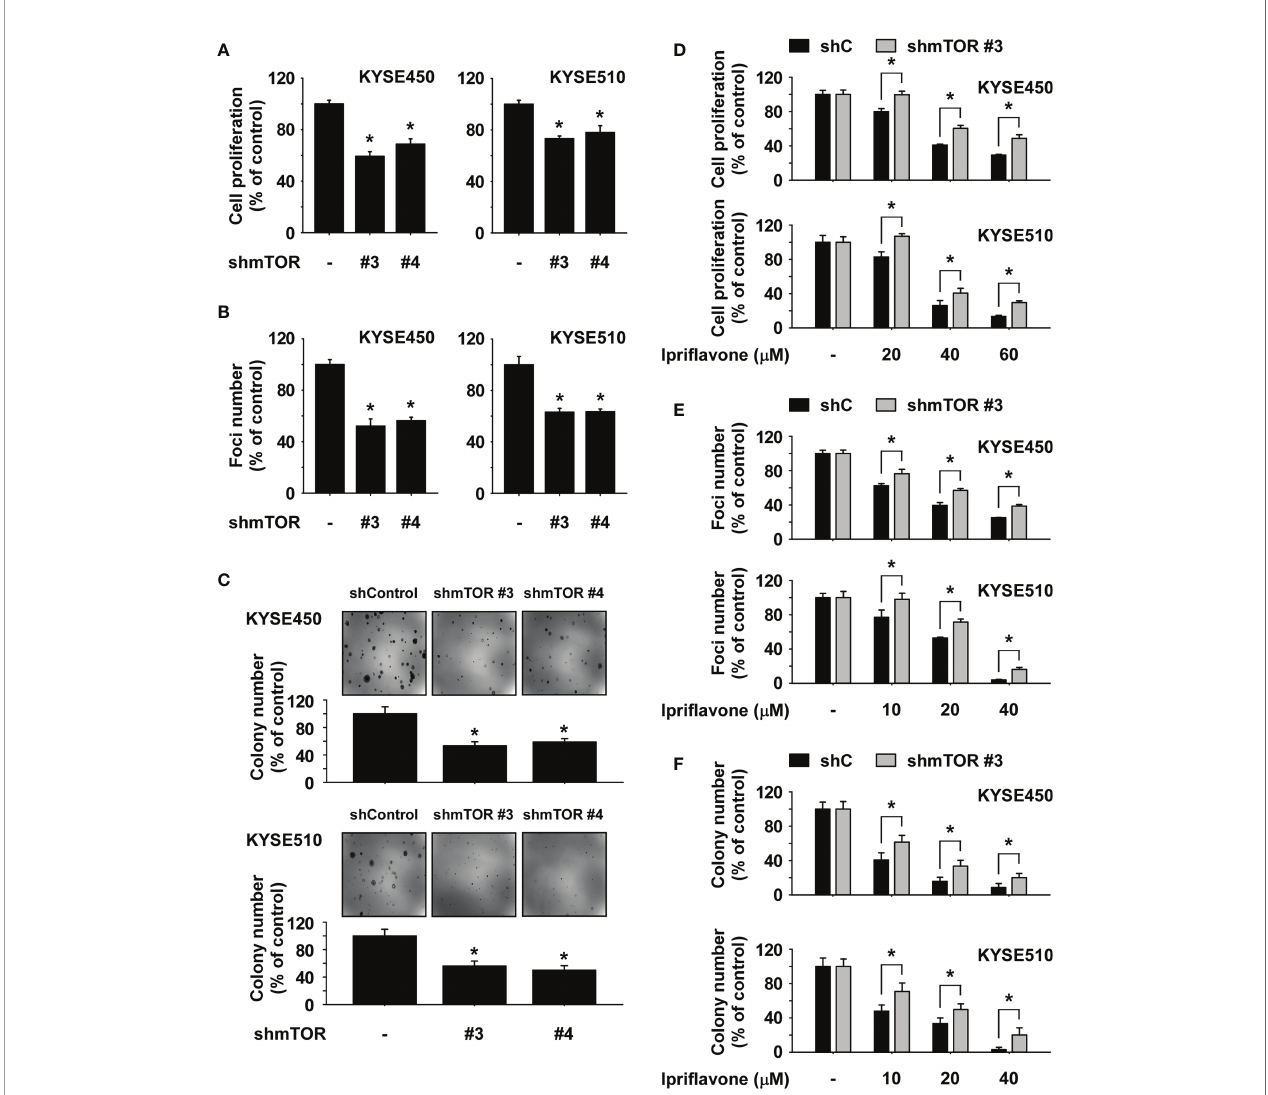
FIGURE 5 | The inhibition of ESCC cell growth by Ipri fl avone is dependent on the mTOR signaling pathway. Effect of mTOR knockdown on anchorage-dependent growth (A) , number of foci formation (B) and anchorage-independent growth (C) in ESCC cells. Cells were seeded and incubated for 48 h, 7 days or 2 weeks respectively (A – C) . Effect of Ipri fl avone on ESCC cell growth was assessed in KYSE450 and KYSE510 stable cell lines that express shmTOR #3 or shControl. Cells were treated with Ipri fl avone for 48 h (D) , 7 days (E) or 2 weeks (F) respectively, and cell growth was determined by (D) MTT assay, (E) foci formation or (F) soft agar assay. All data are shown as means ± S.D. of triplicate values from 3 independent experiments and the asterisk (*) indicates a signi fi cant ( p < 0.05)